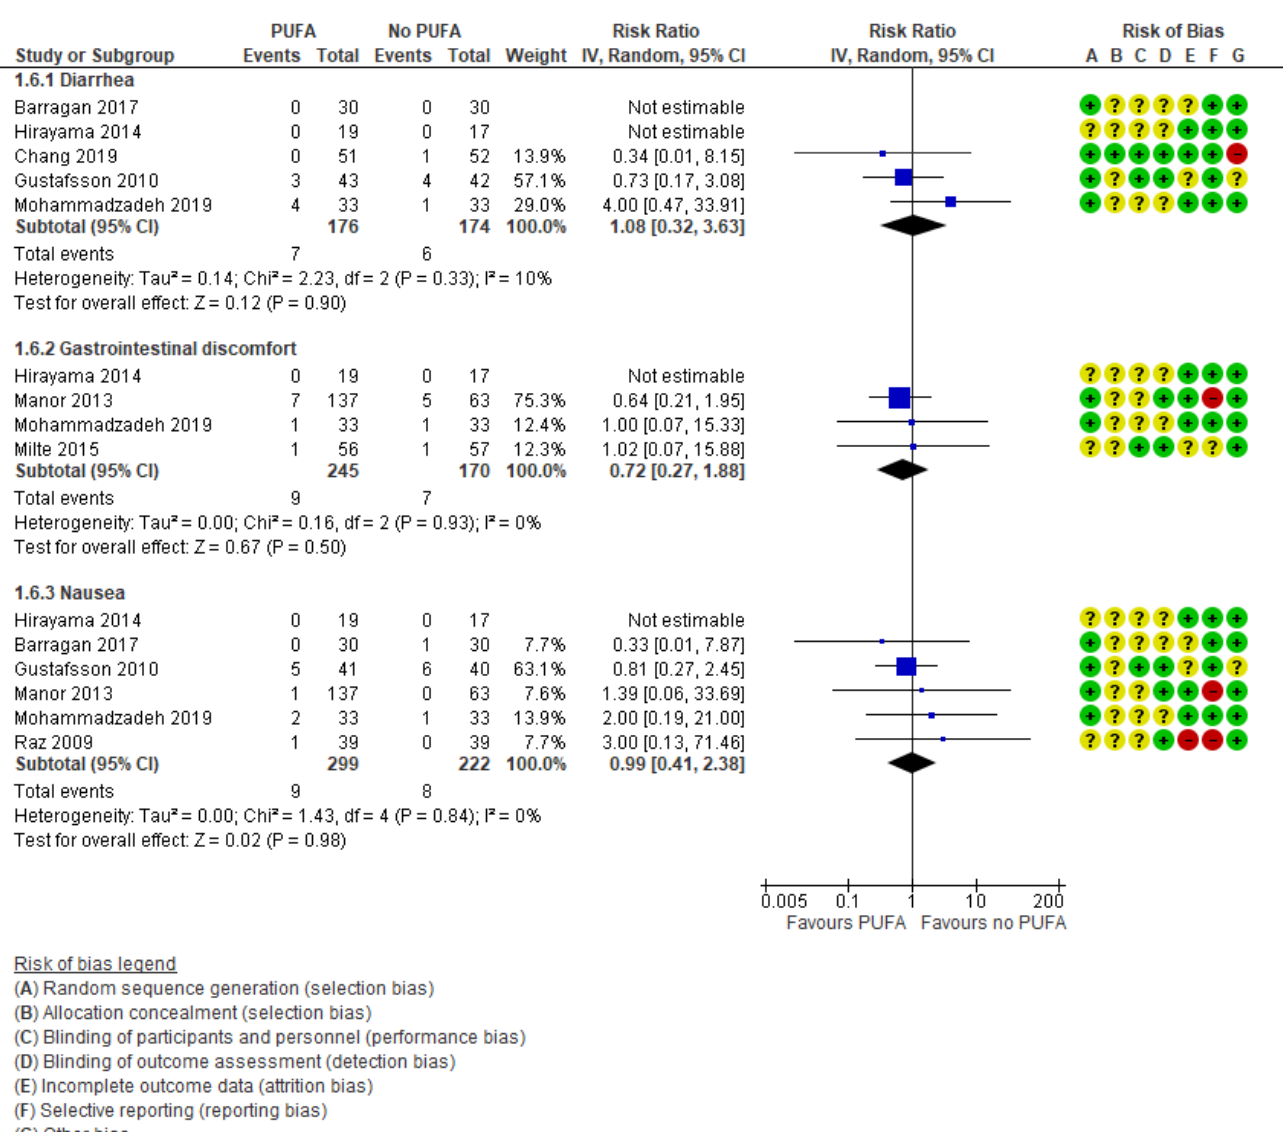
Figure 8. Forest plot of comparison: PUFA vs. placebo, outcome: side effects (end of treatment). Blue square indicates summary estimates of the individual studies. Black diamond indicates total summary effect estimate.